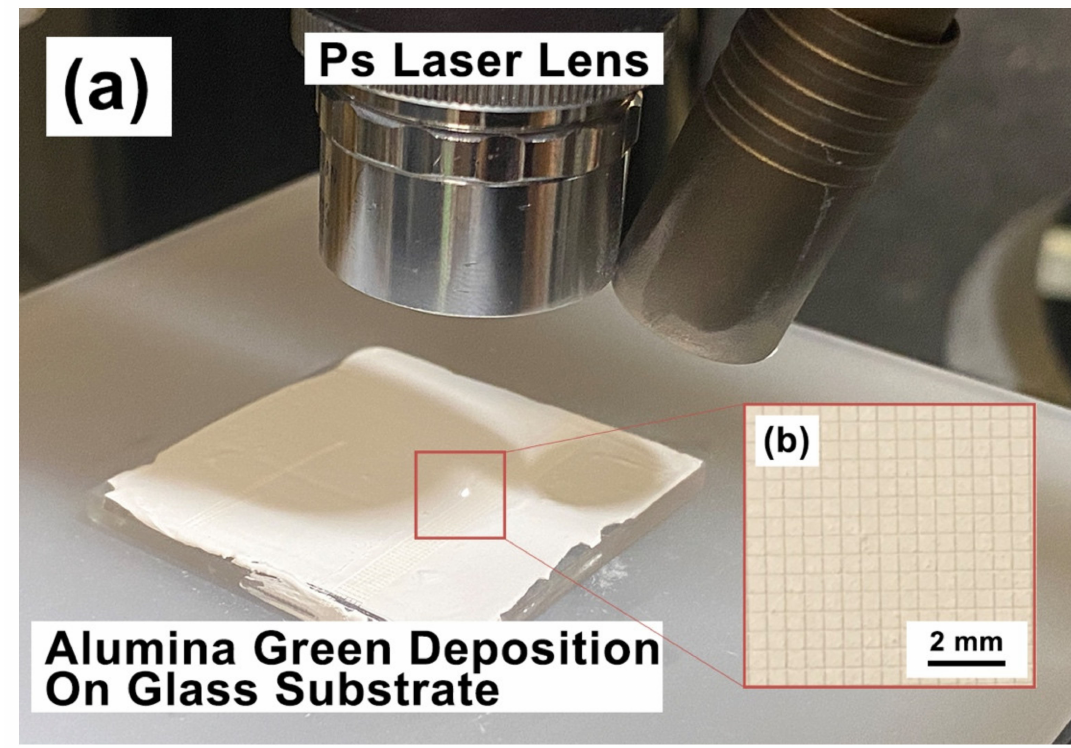
Figure 1. PS laser micromachined green alumina arrays. ( a ): PS laser micromachining processing; ( b ): the alumina layer after PS laser micromachining, showing the sample array